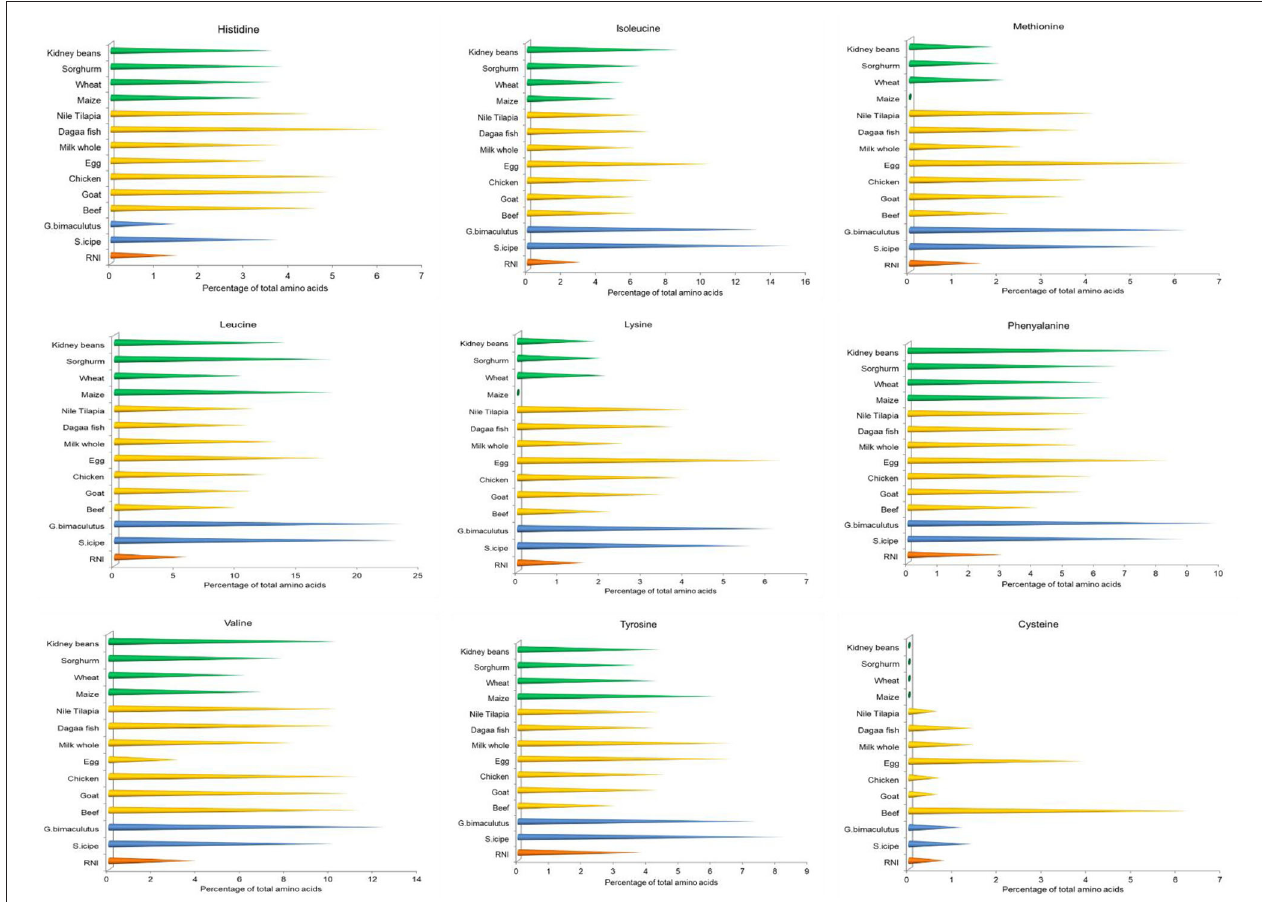
FIGURE 3 | Comparison of selected essential amino acids content of crickets ( Scapsipedus icipe and Gryllus bimaculatus ), animal and plant-based sources. Amino acid data for plant and animal sources was extracted from FAO/GoK (31), while that of the recommended nutrient intake (RNI) was obtained from FAO/WHO/UNU (56).